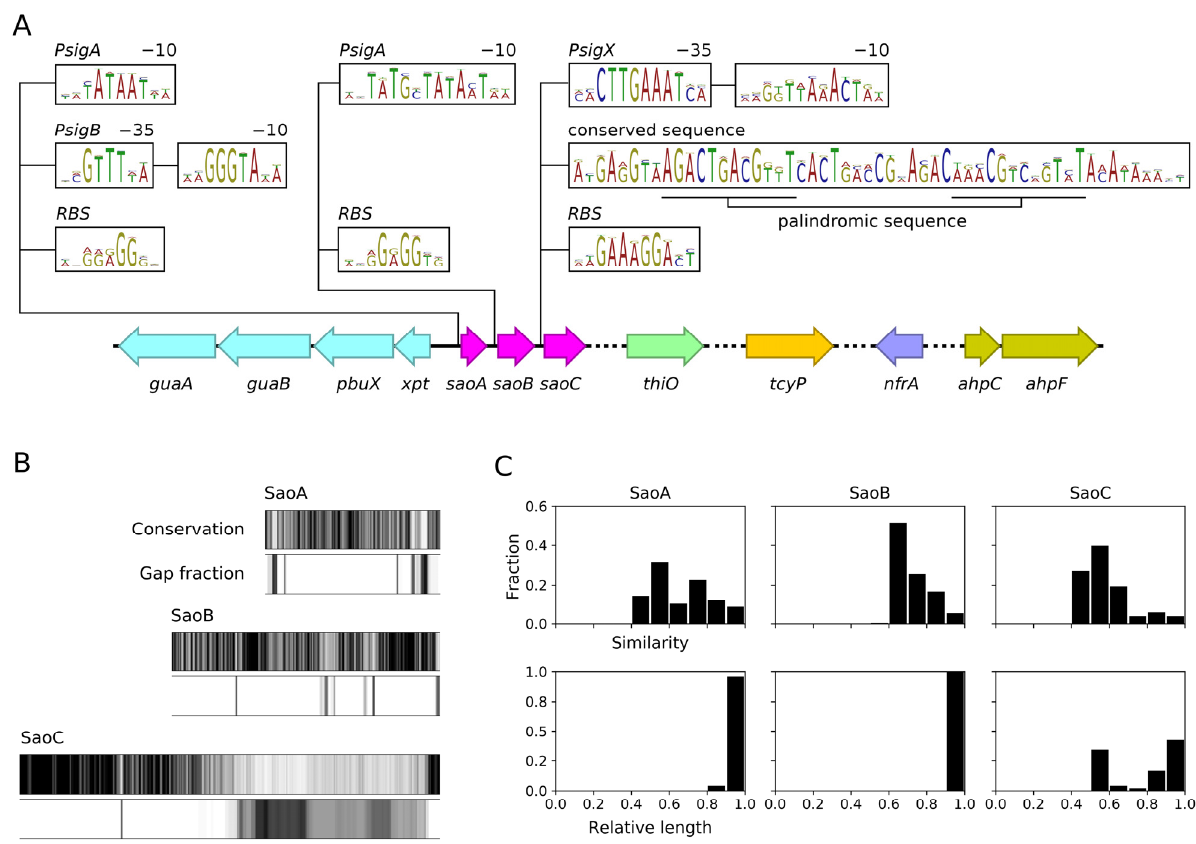
Figure 1. The genetic context of saoABC operon and variability of sequences of the encoded proteins among 47 staphylococcal species. ( A ) Upstream of saoABC operon there is an operon coding for xanthine phosphoribosyltransferase ( xpt ), purine permease ( pbuX ), IMP dehydrogenase ( guaB ) and glutamine-hydrolyzing GMP synthase ( guaA ), genes coding for proteins related to de novo guanine biosynthesis and the purine salvage pathway. Downstream, genes coding for glycine oxidase ( thiO ), L-cystine transporter ( tcyP ), oxygen-insensitive NADPH nitroreductase ( nfrA ) as well as an operon coding for alkyl hydroperoxide reductase subunits C (peroxiredoxin, ahpC ) and F ( ahpF ). Dashed lines represent variable sequence fragments where other genes are found on a species-specific basis. Upstream of saoABC operon genes a few conserved motifs are found. Next to promoters for σ A ( PsigA ) and σ B ( PsigB ) as well as ribosome binding sites (RBS) unknown to date in staphylococci motifs are observed. These include a putative promoter for an unknown putative σ X factor ( PsigX ) and a conserved span of sequence containing a palindromic repeat. ( B ) Conservation plots of SaoA, SaoB and SaoC protein sequences show that whereas SaoA and SaoB protein sequences are conserved among different staphylococcal species, SaoC sequence displays an unusual pattern of conservation with approximately 150 aa N-terminal fragment and a short 12 aa C-terminal motif being conserved, and the remaining span of the sequence variable in respect to amino acid sequence as well as its length. ( C ) Pairwise sequence similarity among SaoA, SaoB and SaoC protein sequences (top) and their relative length (bottom). SaoA and SaoB sequences are conserved and of very similar lengths among all analysed staphylococcal species with SaoB sequence being the most conserved of all three. On the other hand, SaoC sequence is relatively less conserved and of highly variable length with discernible short and long variants.